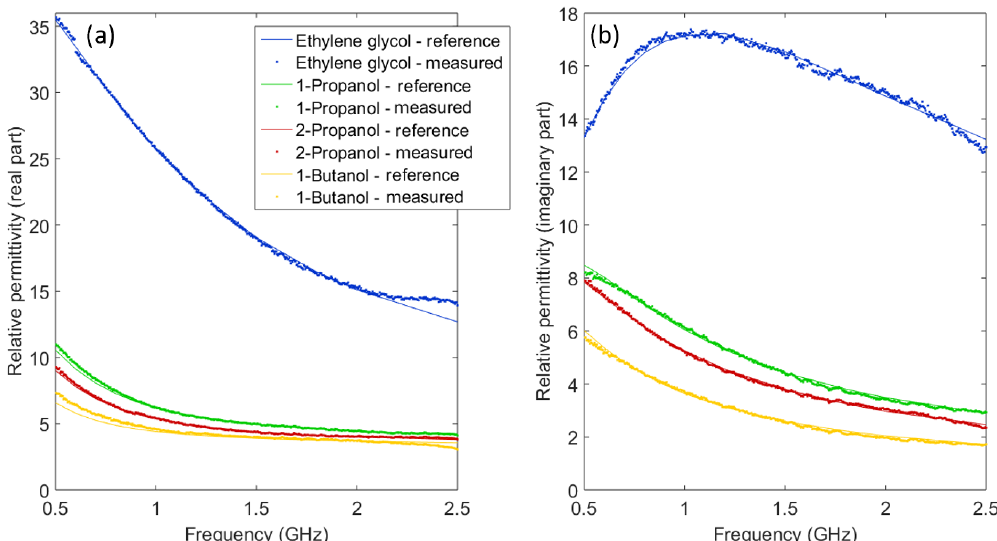
Figure 5. Real (a) and imaginary (b) relative permittivity (unitless) of various well-known liquid standards. The temperature of the reference curve is 20 ◦ C.